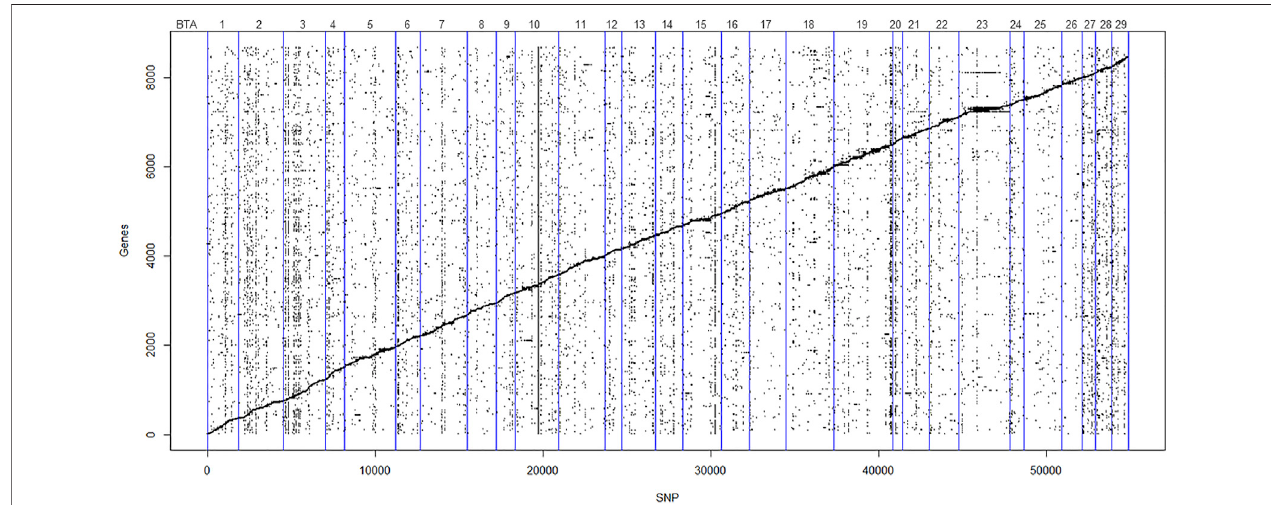
FIGURE 2 | Scatter plot of the affected genes and eQTL (FDR < 0.05). The Y -axis represents gene order in relation to chromosome position in the Bos taurus genome, and X -axis represents the SNP order in relation to chromosome position in the Bos taurus genome. Points scattered diagonally indicates cis-eQTL. Points scattered vertically indicate trans-eQTL. The vertical blue lines denote individual autosomal